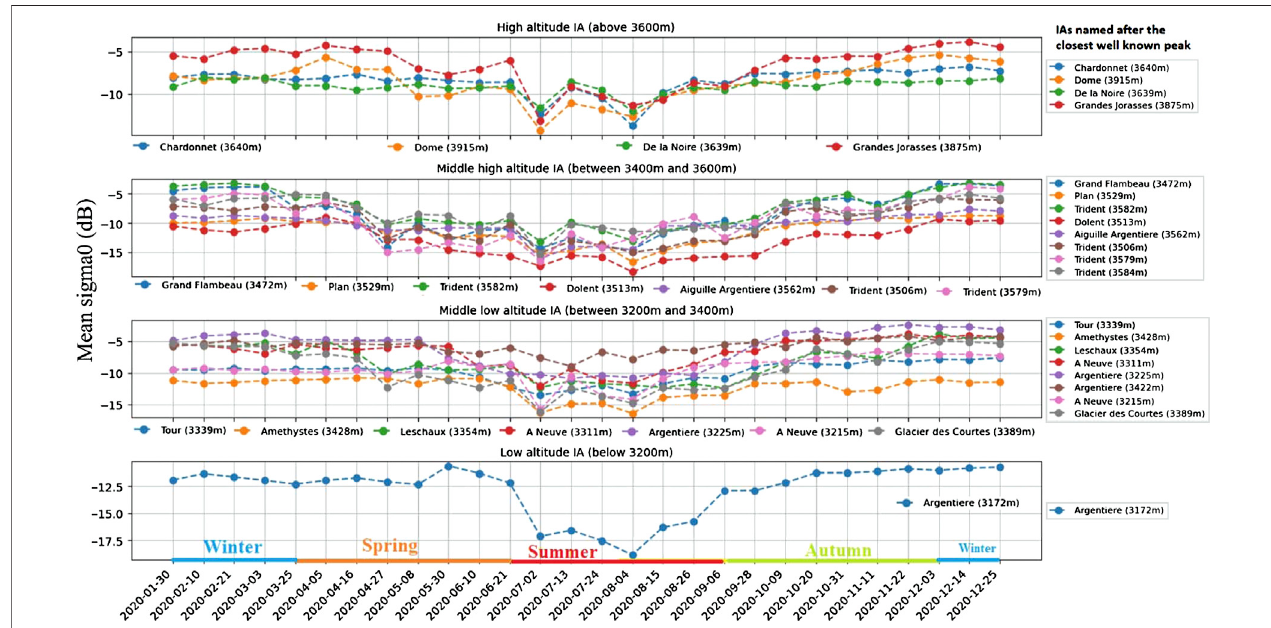
FIGURE 6 | Temporal backscattering pro fi le for 19 visible IAs classi fi ed depending on their elevation using 28 PAZ images in 2020. Altitudes in m a.s.l.